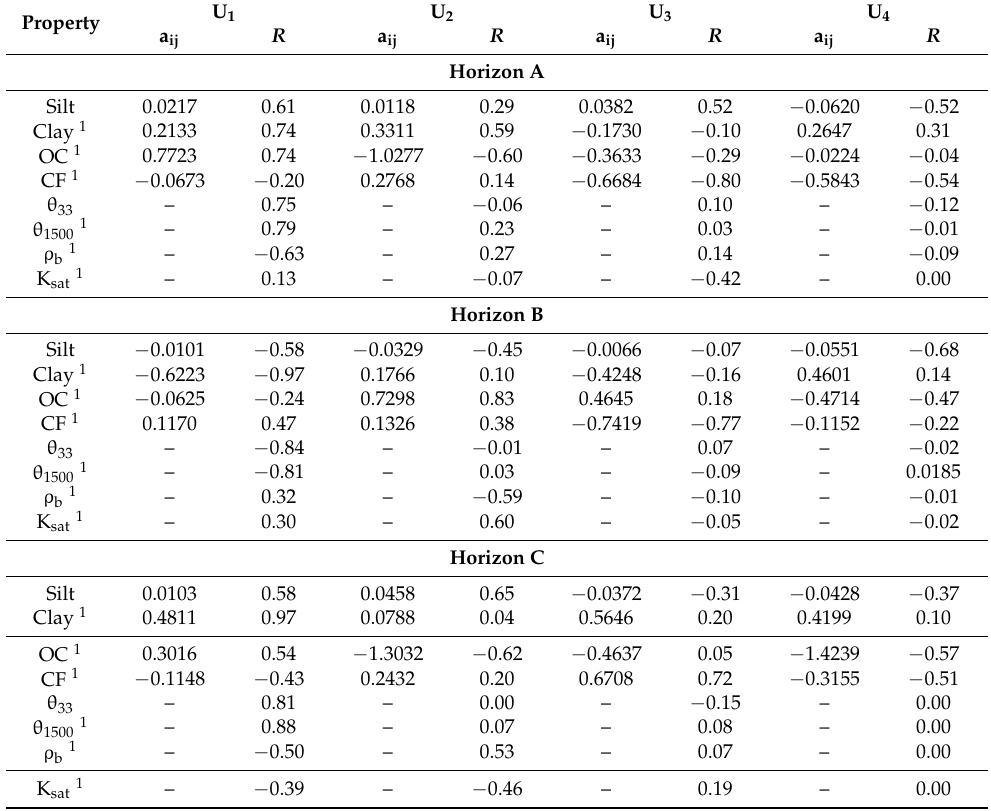
Table 6. Canonical coefficients a ij and correlation coefficients generated for each canonical